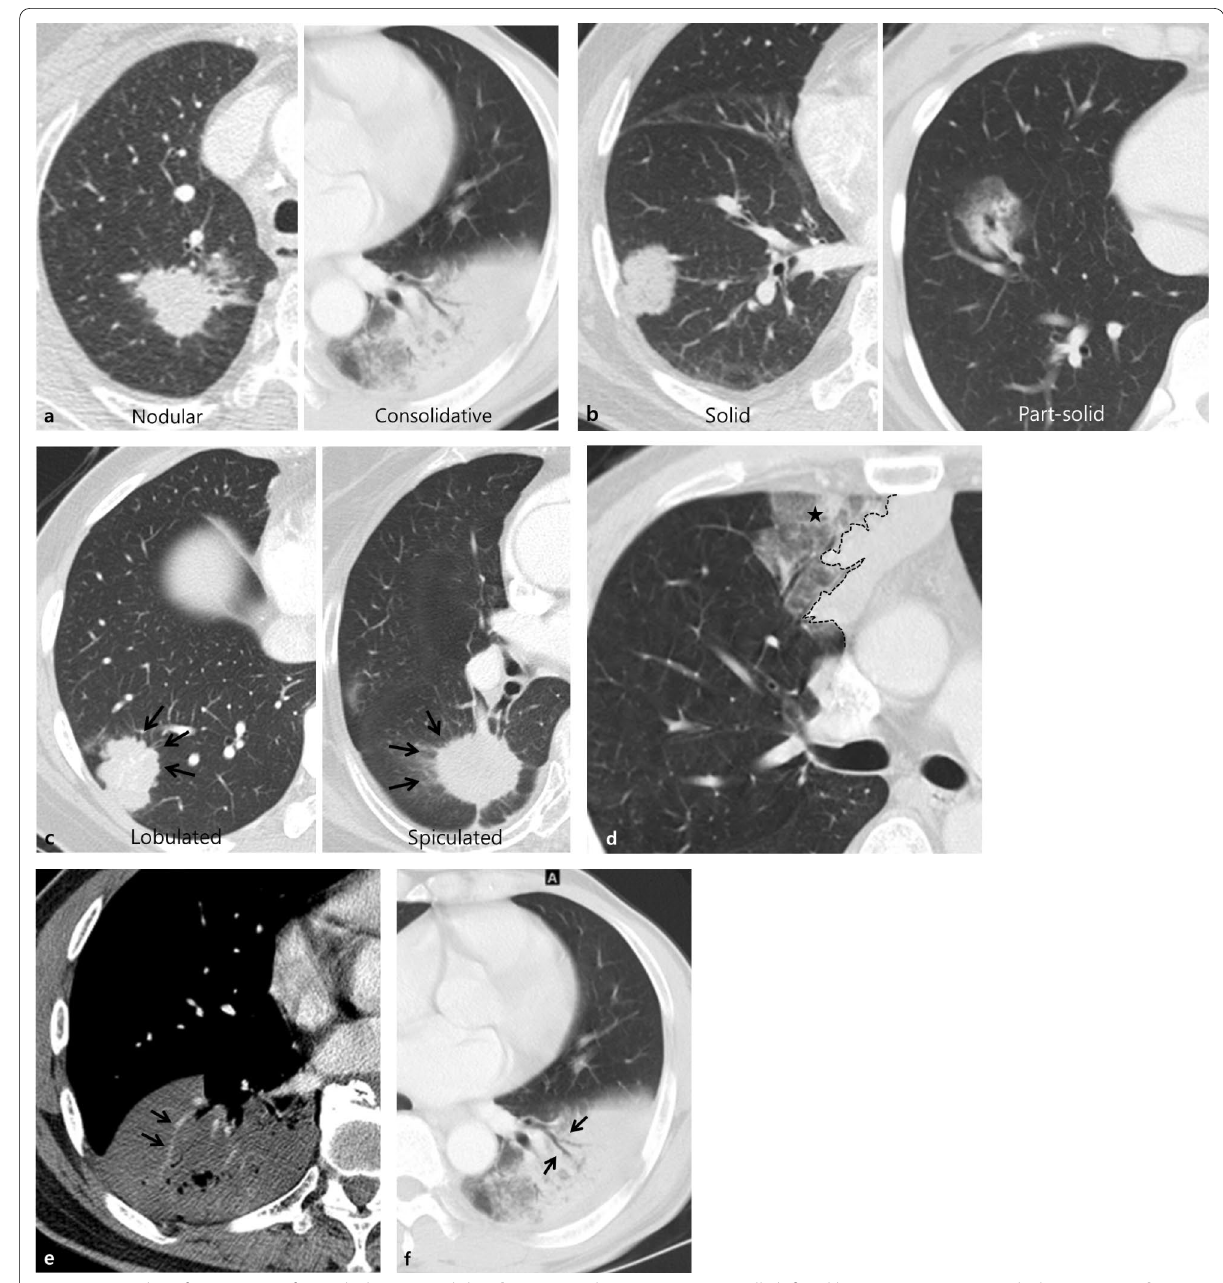
Fig. 1 Examples of CT images of morphology ( a ), solidity ( b ), margin characteristics ( c ), well-defined heterogeneous ground-glass opacity ( d ), CT angiogram sign ( e ), CT air-bronchogram sign ( f ) showing typical features of invasive mucinous adenocarcinomas of the lung. Well-defined heterogeneous ground-glass opacity (asterisk) defined as the combination of consolidation and ground-glass opacity detected beyond the imaginary margin of the lesion (dashed